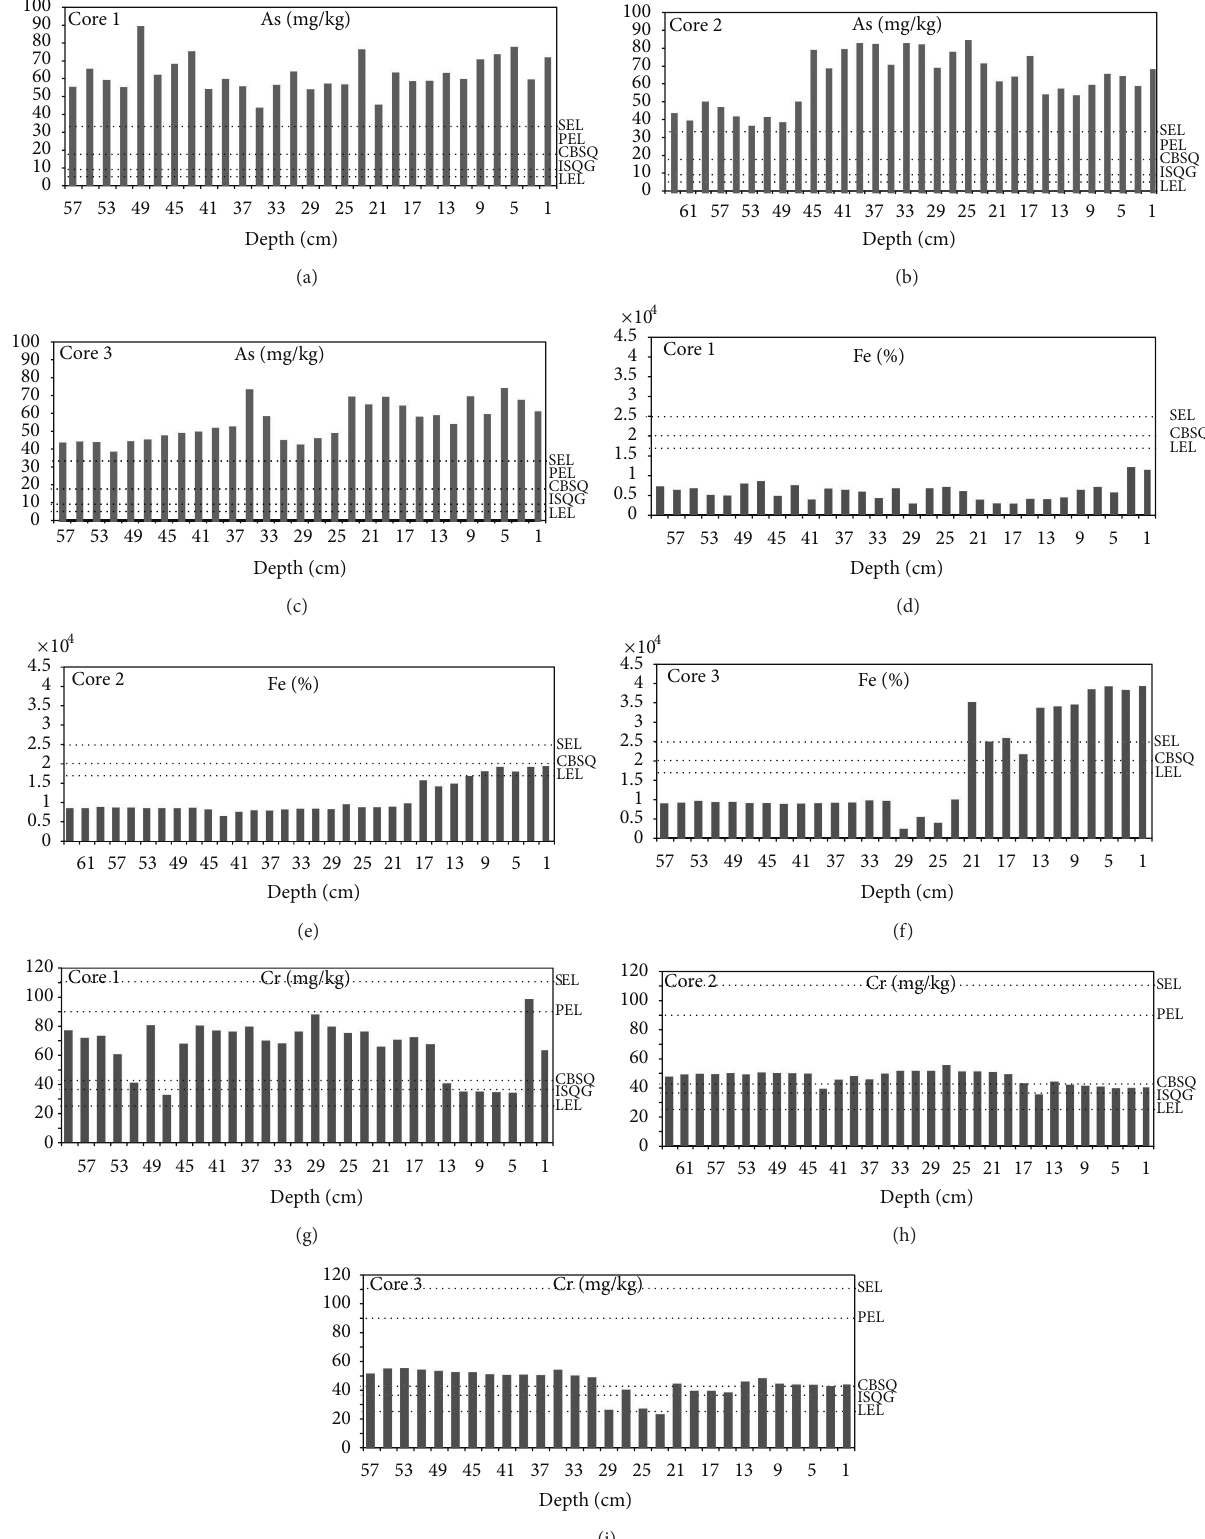
Figure 5: Pollution status of Bera Lake sediments caused by three metallic elements (As, Fe, and